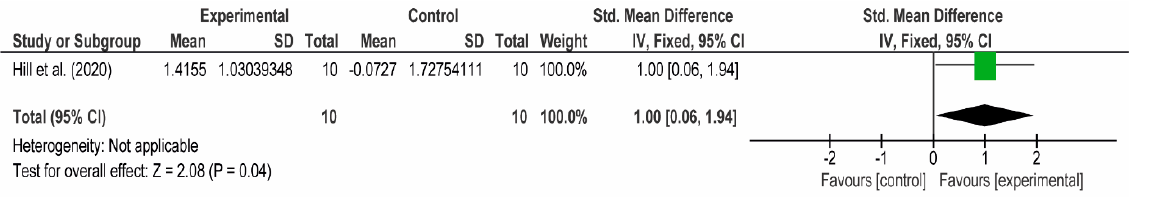
Figure 17. The effect size of 4- weeks of concentric low-load (at 30% of concentric elbow flexion peak torque) forearm flexion-extension training on increasing the biceps brachii CSA.